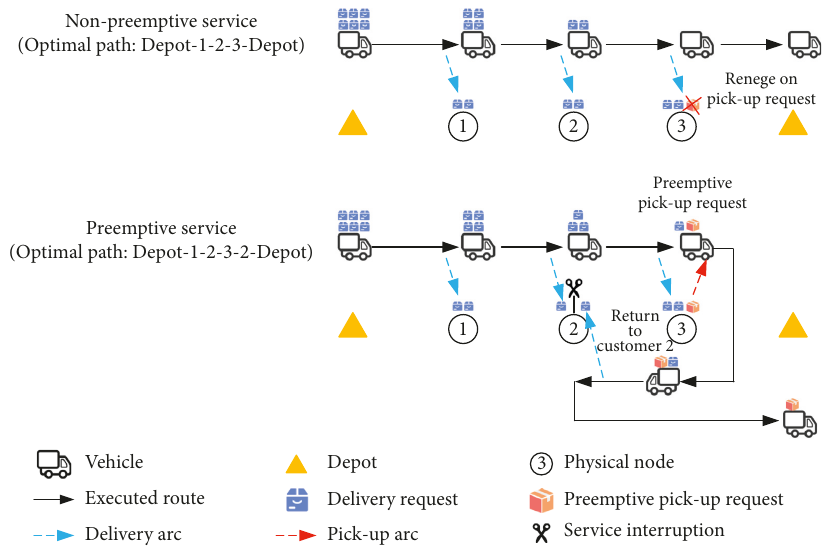
Figure 2: Illustration of non-preemptive and preemptive